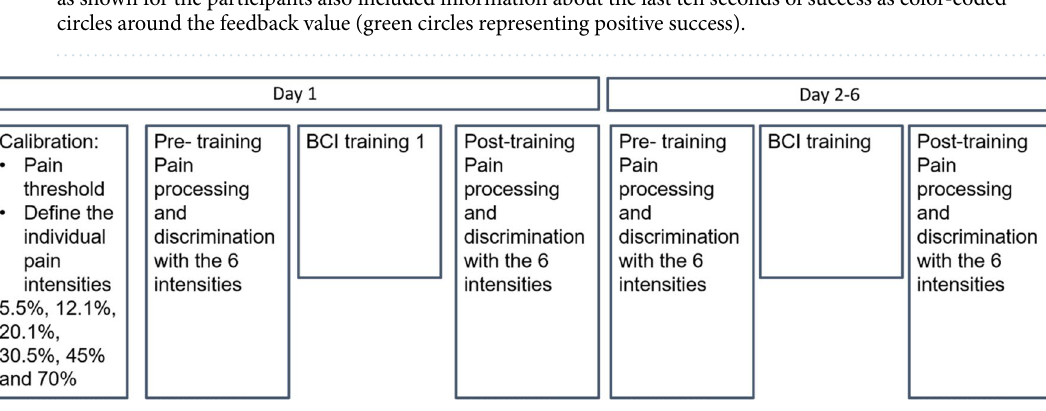
Figure 7. Overview of the experimental design. At the first day the pain intensities were individually calibrated. Before and after each training pain processing and discrimination was